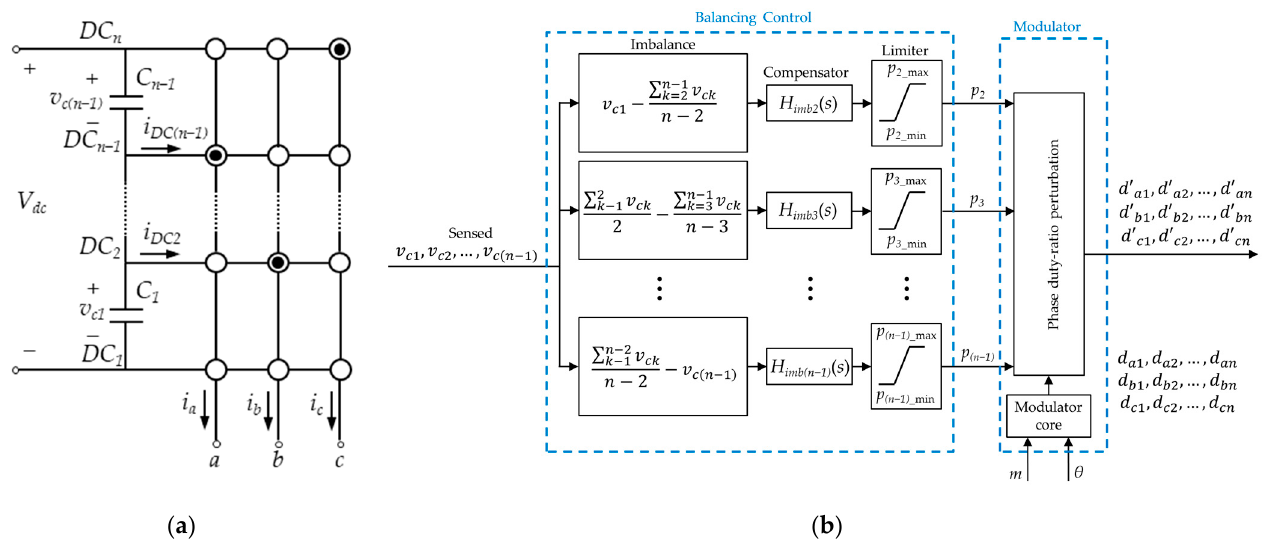
Figure 15. N -level three-phase converter: ( a ) functional schematic; ( b ) balancing control structure [124].